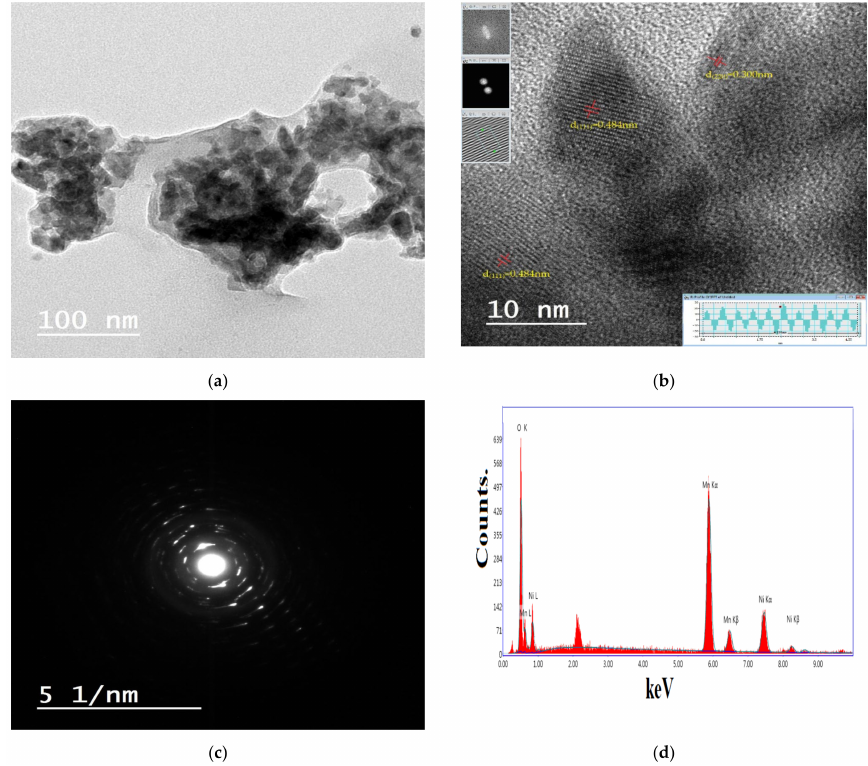
Figure 5. (( a ): HRTEM, ( b ): FFT, ( c ): SAED and ( d ): EDX) images of the S2